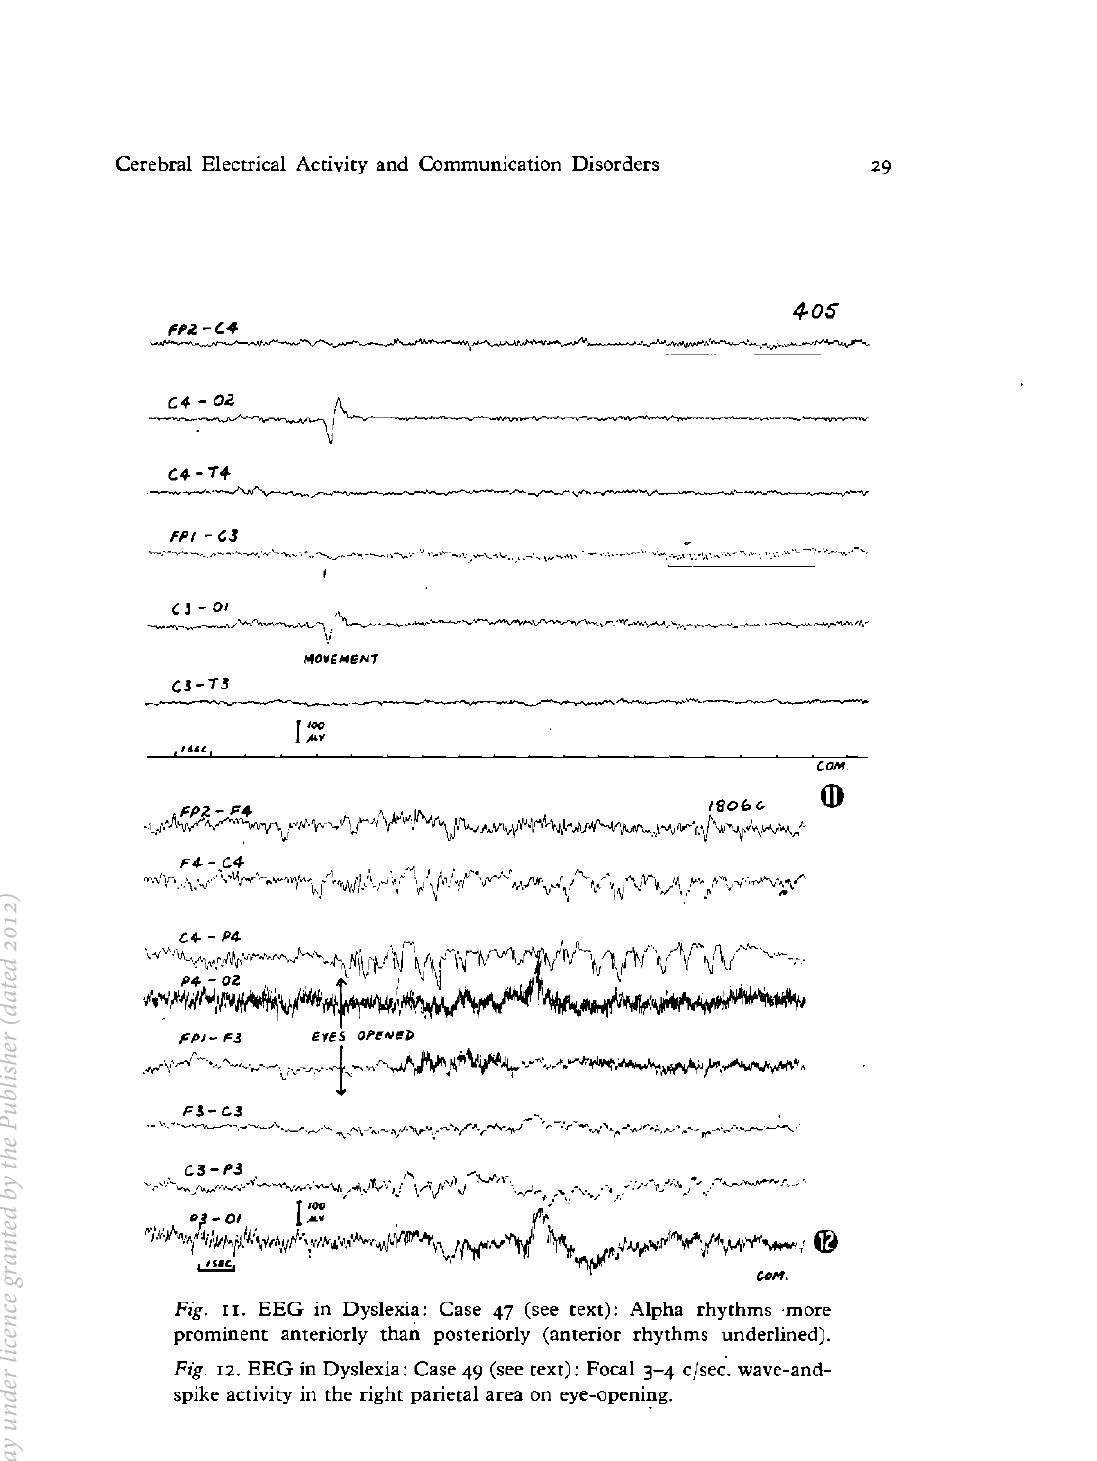
Fig. II. EEG in Dyslexia: Case 47 (see text): Alpha rhythms more prominent anteriorly than posteriorly (anterior rhythms underlined). Fig. 12. EEG in Dyslexia: Case 49 (see text): Focal 3-4 c/sec. wave-and- spike activity in the right parietal area on eye-opening.